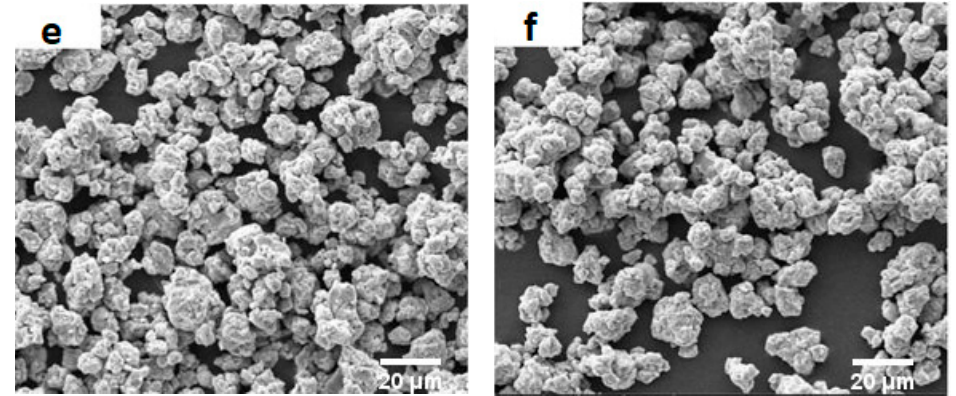
Figure 8. SEM images of TiFe-based milled products after different milling times: ( a ) without milling, ( b ) 20 h, ( c ) 30 h, ( d ) 40 h, ( e ) 60 h, and ( f ) 90 h. As can be seen in Figure 8, the particles size gradually decreases with the increase of milling time. In the early times of milling, the powders of the raw materials easily deformed by the compressive forces and turn into very thin layers, while relatively brittle particles tend to resist compressive forces. Therefore, brittle particles are less deformed and ductile particles cause connection between brittle particles. This difference in the ductility of particles is believed to be responsible for the wide particle-size distribution of the milled products after relatively lower milling times. With the increase of milling times, more uniformity in particle-size distribution achieved, and noticeable changes in the morphology of particles took place. By increasing the time of HEBM, a homogeneous compound formed with the same chemical composition of the powder mixture. Figure 9 presents the effect of Mn addition on the microstructure of TiFe, Fe20, and Ti20 milled products after 40 h of milling.